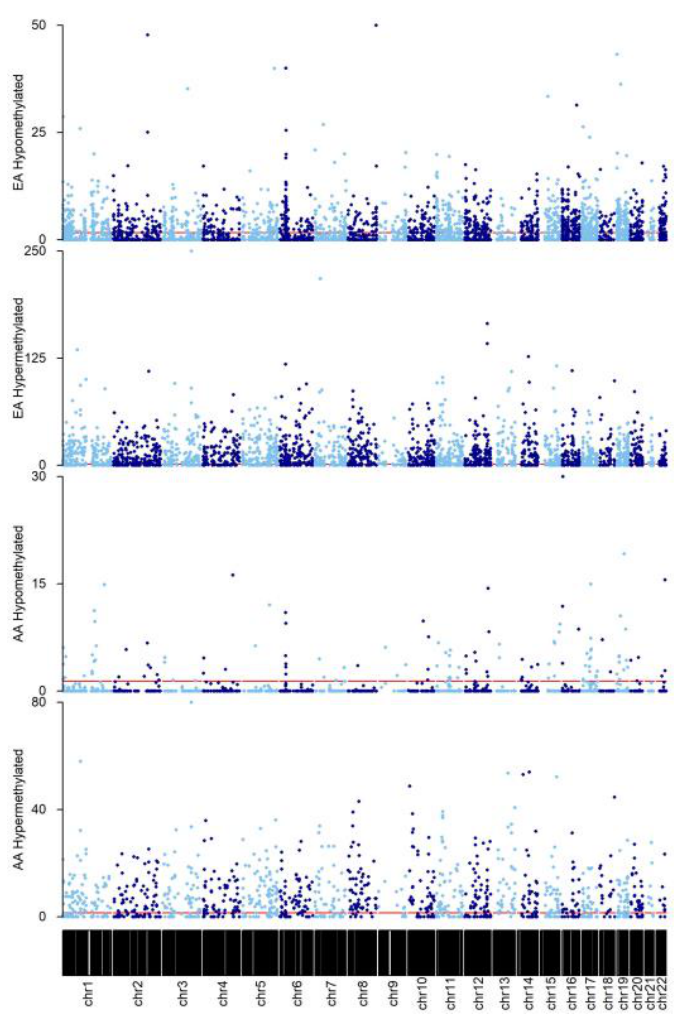
Figure 2. Manhattan plots of DMRs identified in AA and EA rectum. Findings were grouped according to direction of effect for each race. Y-axis represents − log 10 (Bonferroni p value). Horizontal red line indicates the cut-off for significance at P Adjusted = 0.05. For visualization purposes, alternating light and blue colors were used to define datapoints in odd and even chromosomes, respectively.